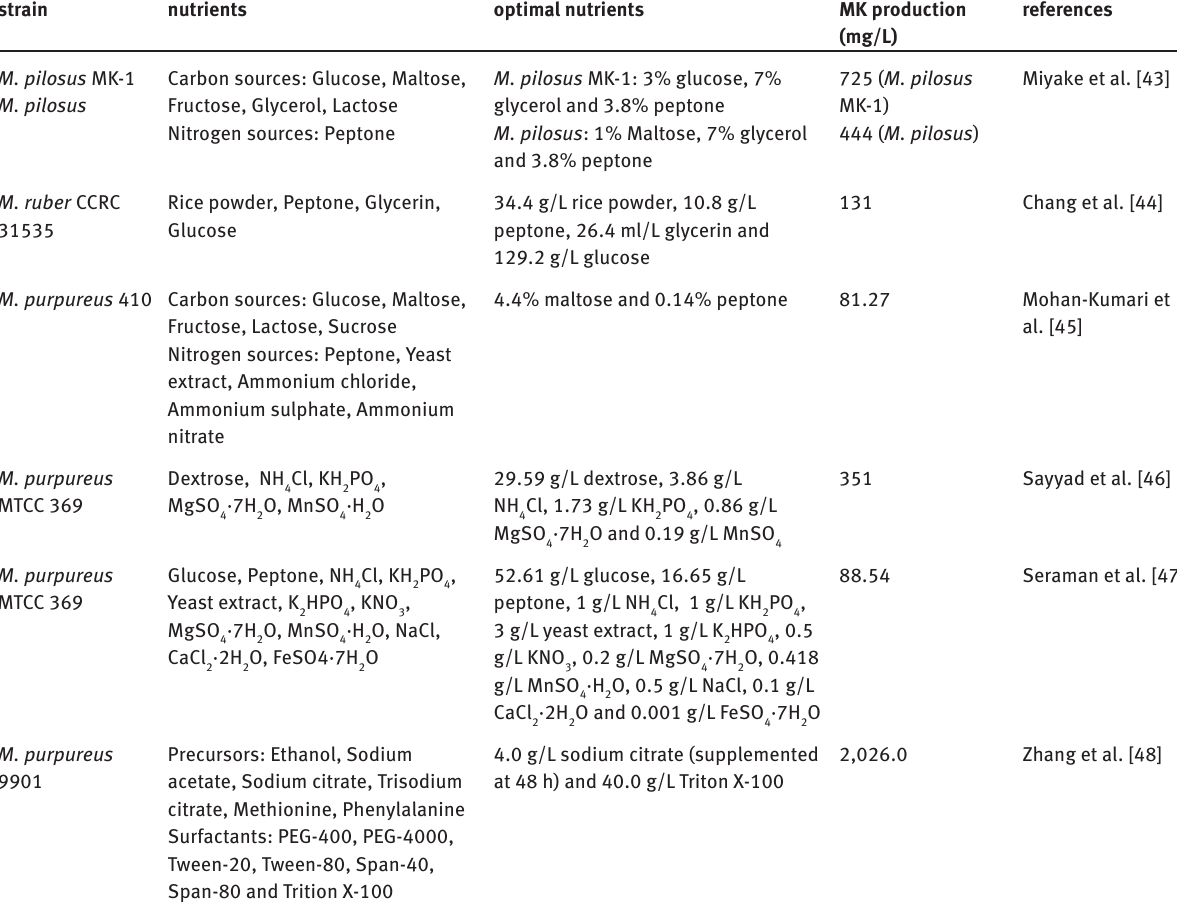
Table 3: Optimization of the SmF Medium Components of Monascus .